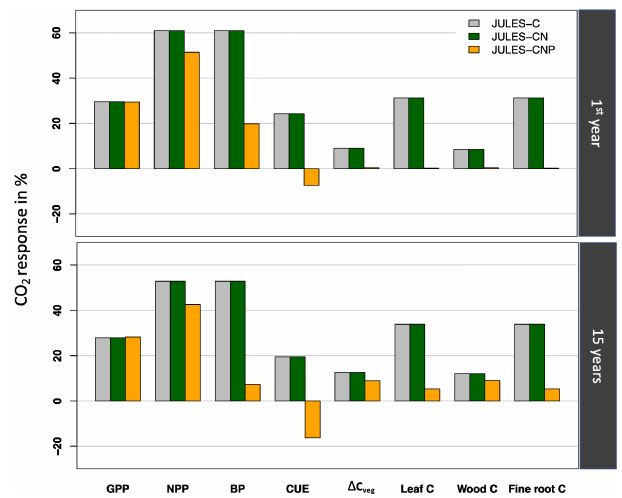
Figure 6. Relative effect of eCO 2 on simulated GPP, NPP, BP, CUE, (cid:49) C veg , leaf C, wood C, and fine root C using three versions of the JULES model over the first year (initial response) and after 15 years (final